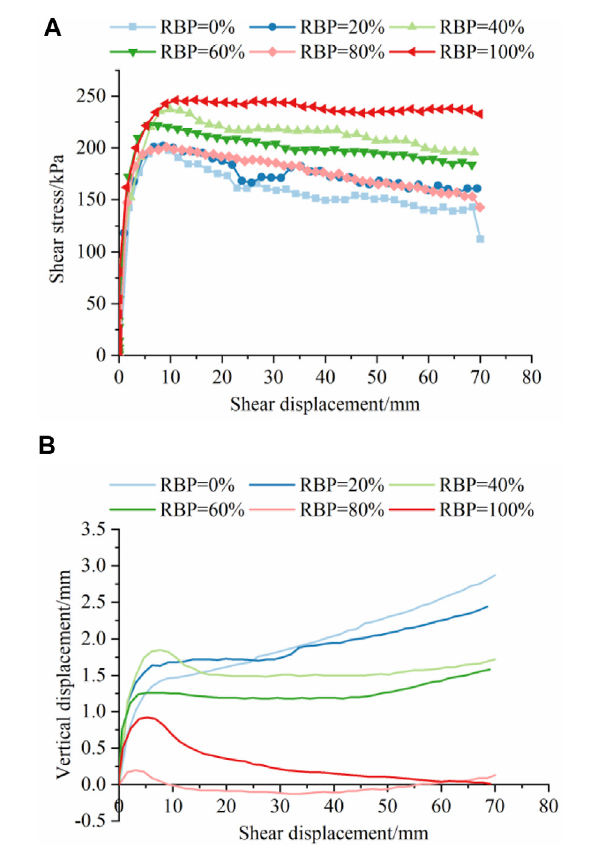
FIGURE 5 Curves of (A) shear stress; (B) vertical displacement with shear displacement of S-RM samples with various RBPs.